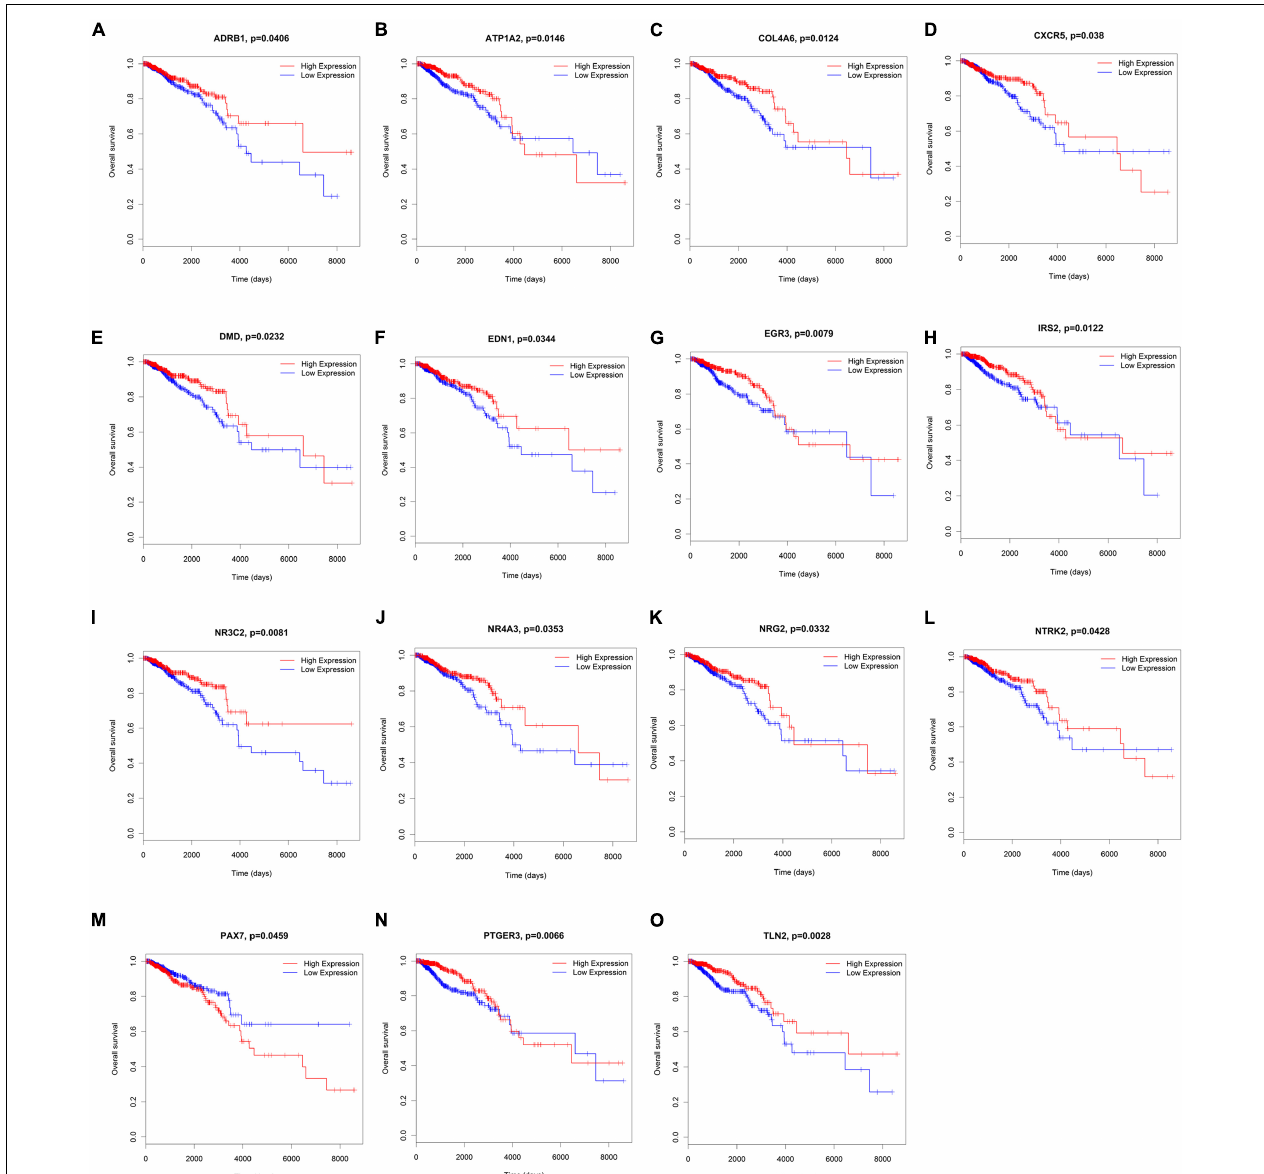
FIGURE 7 | Kaplan–Meier survival curves for 15 mRNAs associated with overall survival. (A) ADRB1, (B) ATP1A2, (C) COL4A6, (D) CXCR5, (E) DMD, (F) EDN1, (G) EGR3, (H) IRS2, (I) NR3C2, (J) NR4A3, (K) NRG2, (L) NTRK2, (M) PAX7, (N) PTGER3, (O) TLN2.